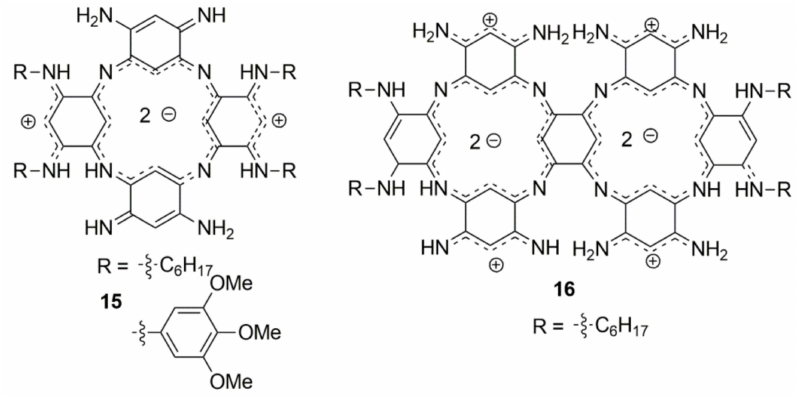
Figure 12. Chemical structures of tetrapyrrol-inspired tetraiminobenzene contained designs of NIR-II absorbing azacalixphyrin ( 15 ) and bisazacalixphyrins ( 16 ).